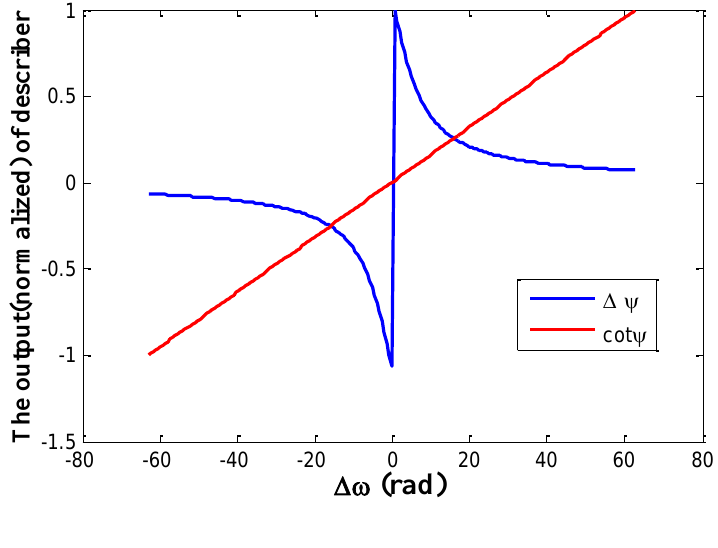
Figure 7. The comparison of the proposed describer (cot φ ) and conventional PLL describer (∆ φ ).